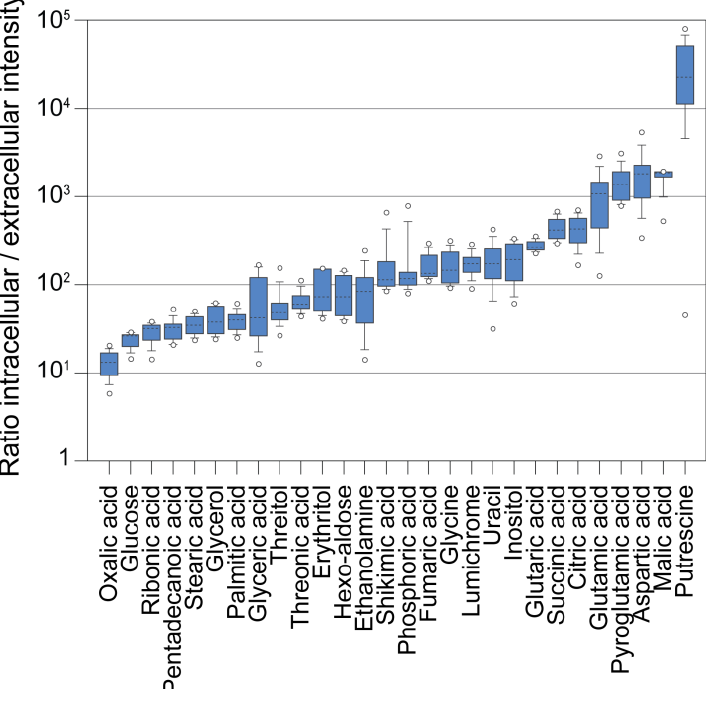
Figure 5. Ratios of intracellular to extracellular metabolite abundance. Measured metabolite responses that have been analyzed in both filtrate samples and cell samples were normalized to the extracted volumes (the total cellular volume was determined with a Coulter Counter), and the ratios of n = 36 samples were plotted as box